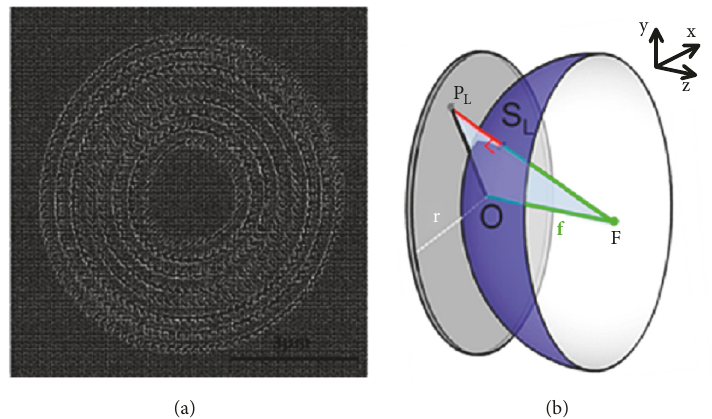
Figure 8: (a) Lens model. (b) Schematic diagram of the ultra-thin flat lens producing a spherical wave of a specific focal length.